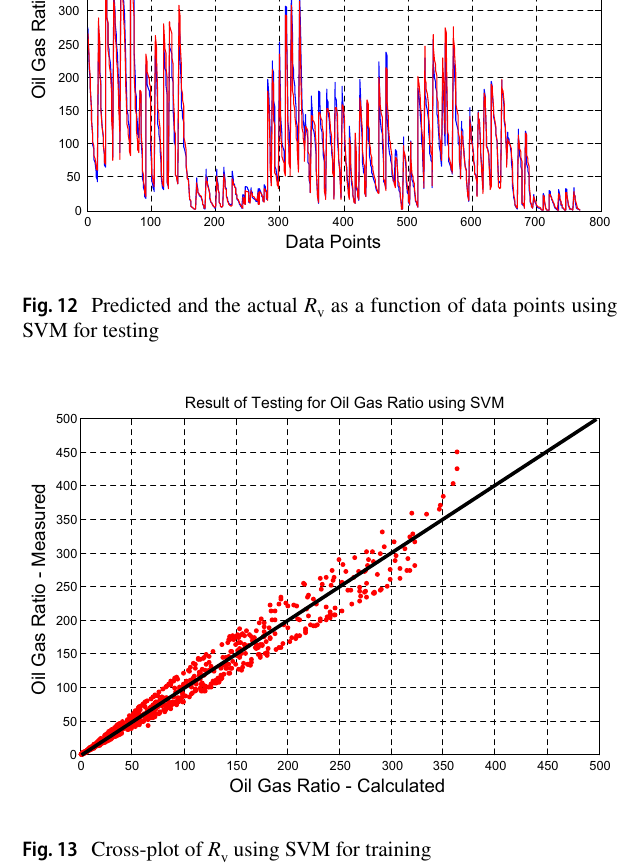
Fig. 10 Cross-plot of R